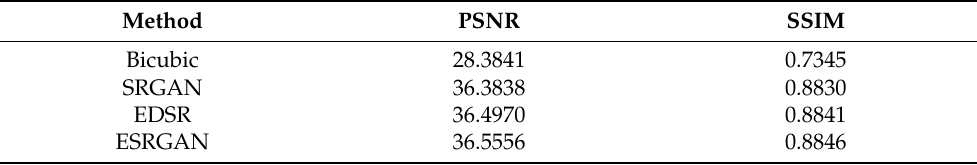
Figure 4. Comparison of the results of different super-resolution methods. Table 1. Comparison of the objective evaluation indicators of different super-resolution methods.